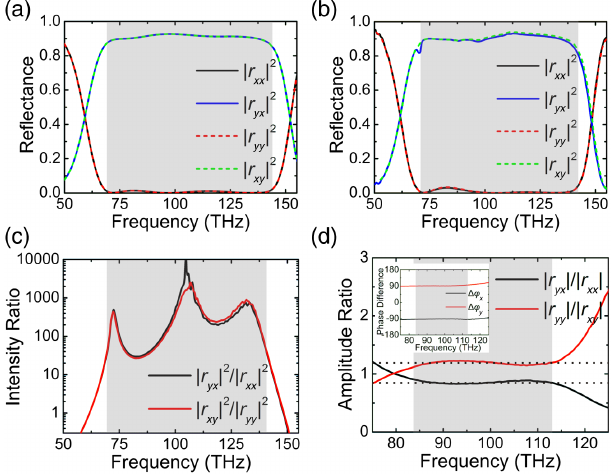
4. (a) Simulated reflectance for a broadband half-wave plate. (b) Experimentally measured reflectance of the fabricated sample, which is in good agreement with simulations. (c) Measured intensity ratio between the x and y components of reflectance. (d) The wave plate to generate the elliptical polarized light has been fabricated. The measurements show that the amplitude ratio between the two components of the reflected light deviates from 1 in the shaded region, whereas the phase difference (inset) between the two orthogonal components remains